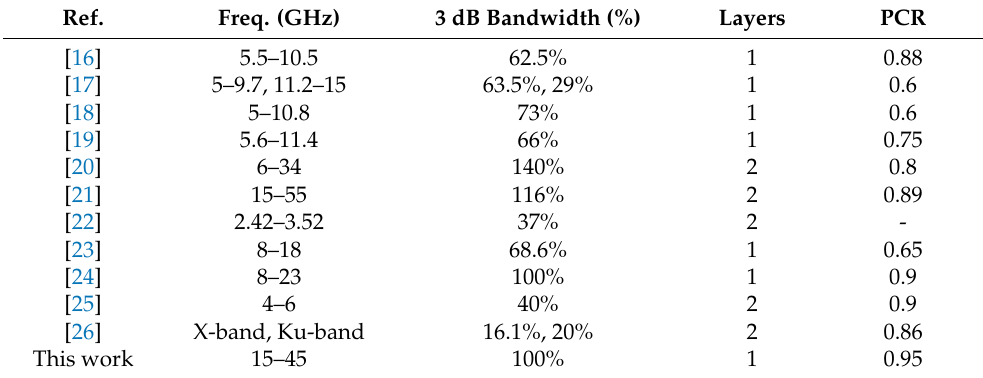
Table 2. A performance comparison of reflective polarization rotators presented in literature. Ref.